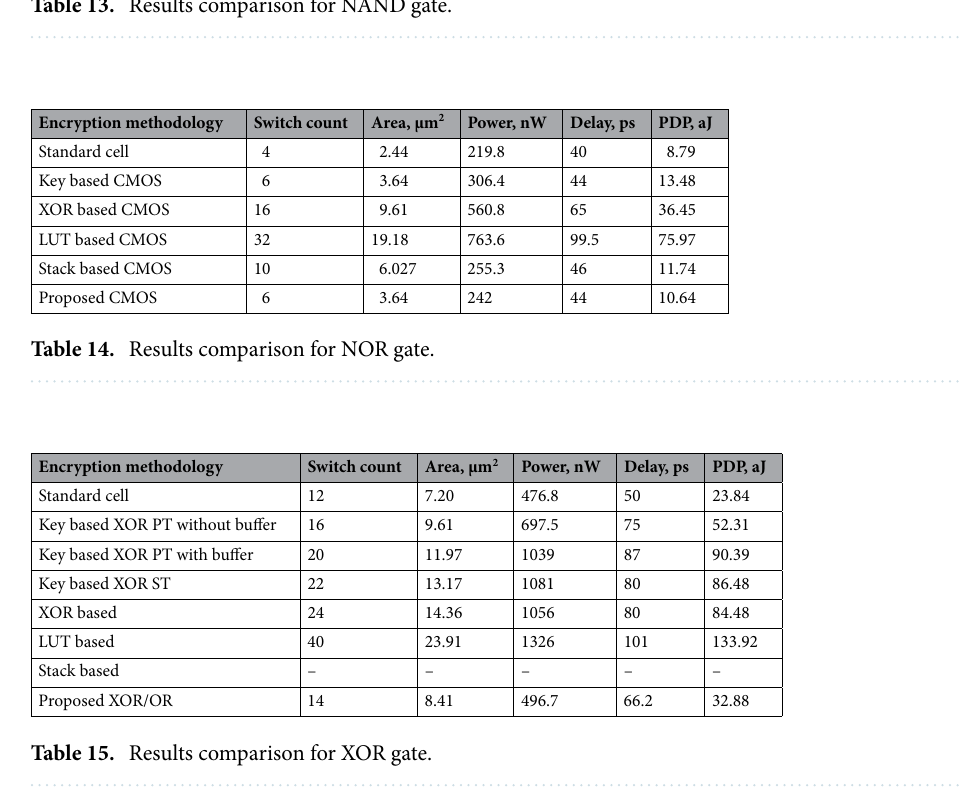
Table 13. Results comparison for NAND gate.